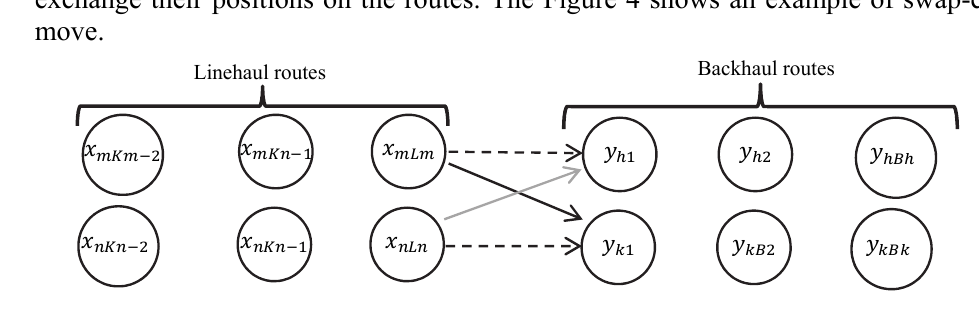
Fig. 4. Example of Swap-connections